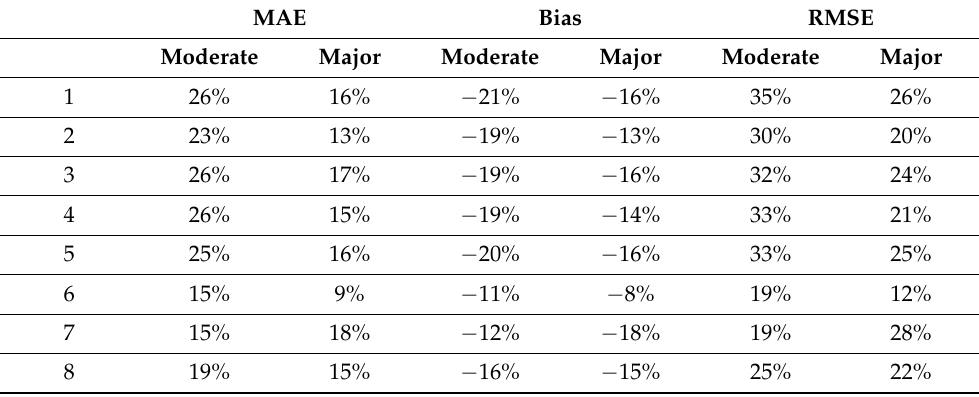
Table 9. Error metrics for log-normal MSA